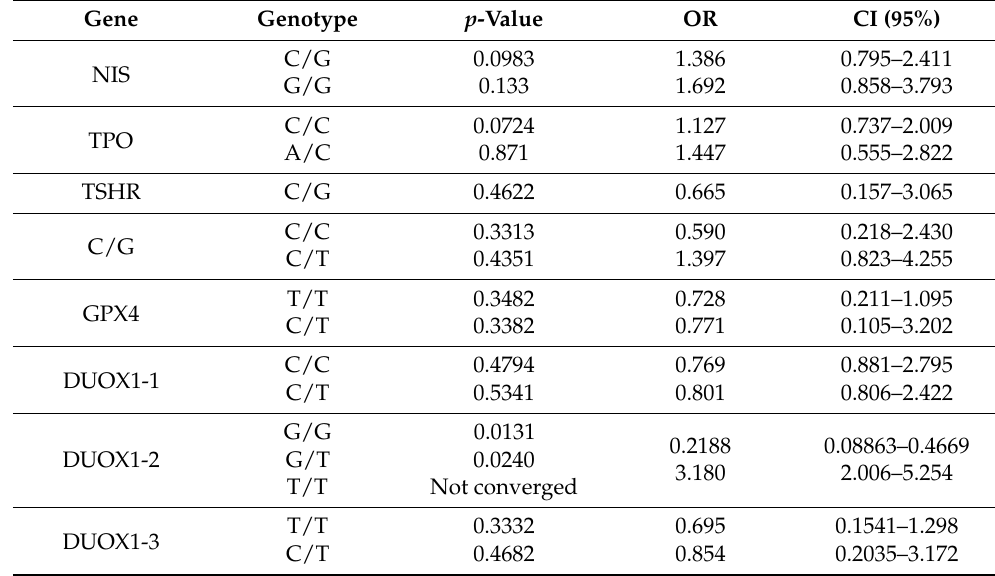
Table 3. The regression analysis for the genotype